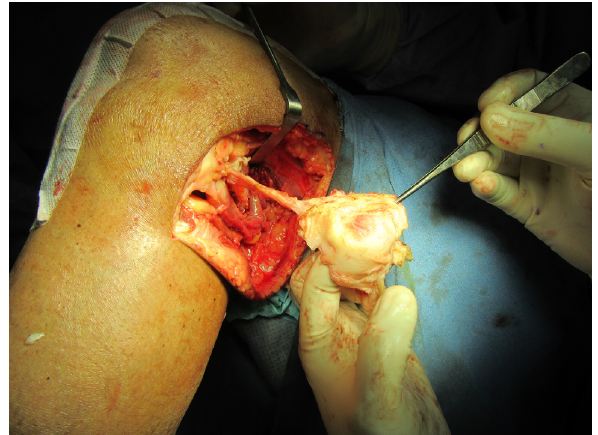
Figure 7. Removal of the cyst in toto. Examination of the inner wall of the cyst reveals smooth and glistening